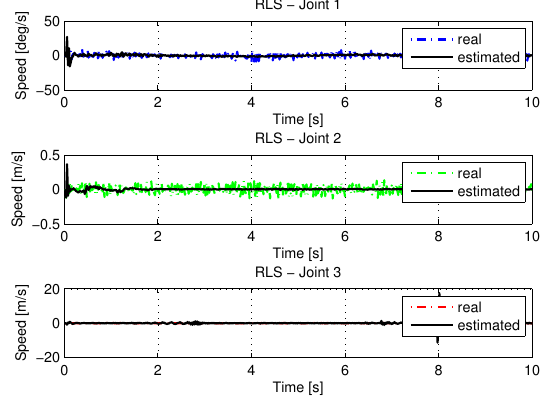
Figure 29. Speed of joints with RLS with noise.